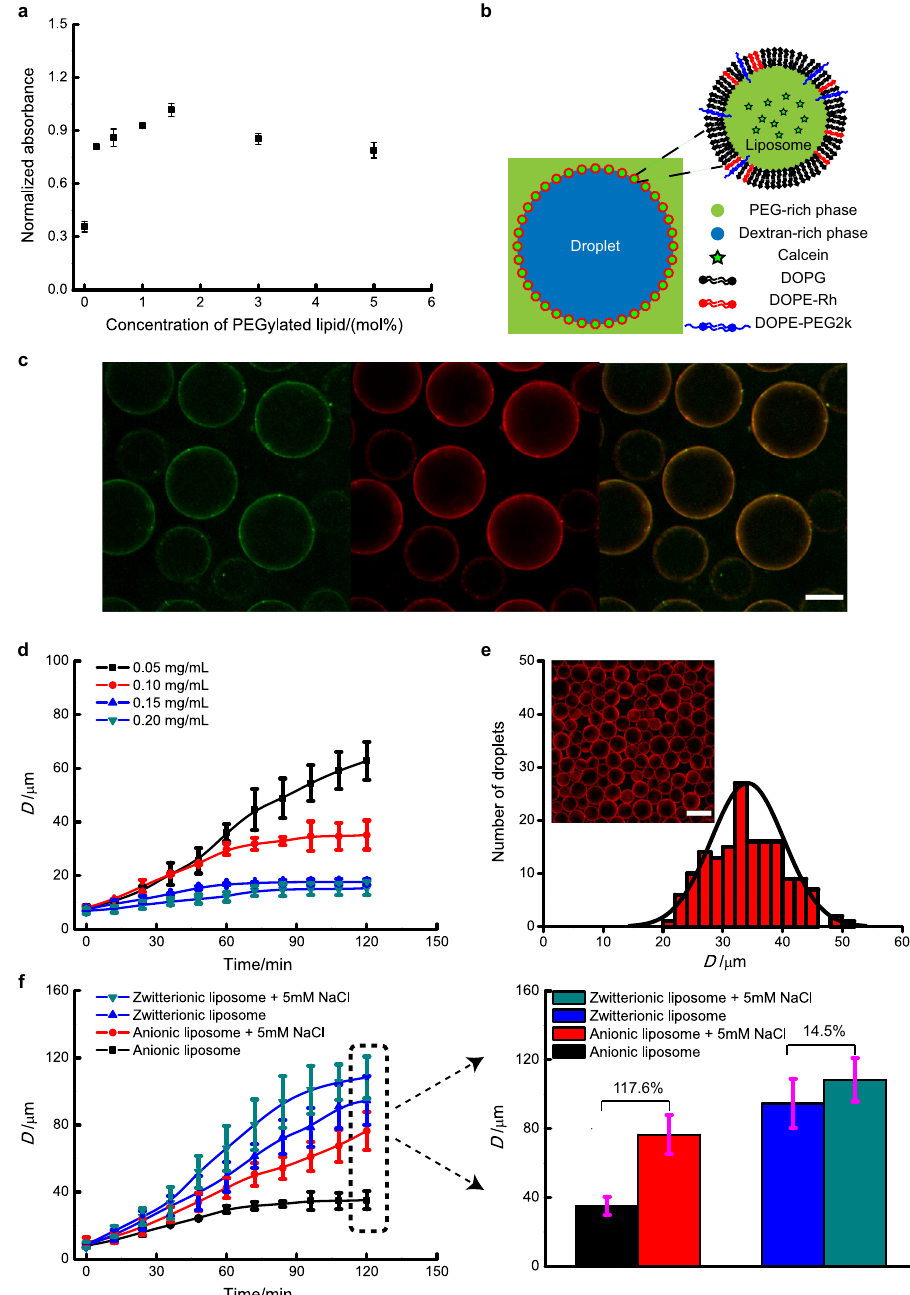
Fig. 2 Characterisation of droplet morphology and stability. a Normalised absorbance (at 650 nm) 8 h after emulsion formation. If emulsions stay stable, it should remain turbid during observation, i.e. the normalised absorbance remains unchanged. A decrease in normalised absorbance can be observed for unstable emulsions. Error bars represent 1 s.d. ( n = 3) for each data set. b Illustration of a liposome-stabilised droplet. DOPG, DOPE-Rh and DOPE-PEG2k corresponds to 1,2-dioleoyl-sn-glycero-3-phospho-(1 ′ -rac-glycerol) (sodium salt), 1,2-dioleoyl-sn-glycero-3-phosphoethanolamine-N-(lissamine rhodamine B sulfonyl) (ammonium salt), and 1,2-dioleoyl-sn-glycero-3-phosphoethanolamine-N-[methoxy(polyethylene glycol)-2000] (ammonium salt), respectively. c Droplets stabilised by Calcein-containing (5 mM) liposomes. From left to right, Calcein channel, Rhodamine channel and an overlay of the calcein and rhodamine channels. Colours were added via Image J. Liposome solution is diluted after size exclusion, which leads to the large droplet size. Scale bar is 50 μ m. d Effect of liposome concentration on droplet stability. D is droplet diameter. Error bars represent 1 s.d. ( n = 50) for each data set. e Droplet size distribution for stable droplets (stabilised with DOPG liposomes). The inset picture corresponds to droplets at 120 min for 0.10 mg/mL in ( d ). Scale bar is 50 μ m. f Effect of liposome type and salt addition on droplet stability. Droplet diameter at 120 min was extracted to draw a histogram in order to show the difference of salt addition on different liposome-stabilised droplets. Error bars represent 1 s.d. ( n = 50) for each data set.